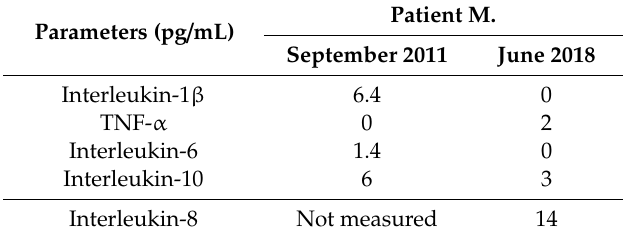
Table 2. Chronological shifts of the cytokine profile in patient M.’s blood